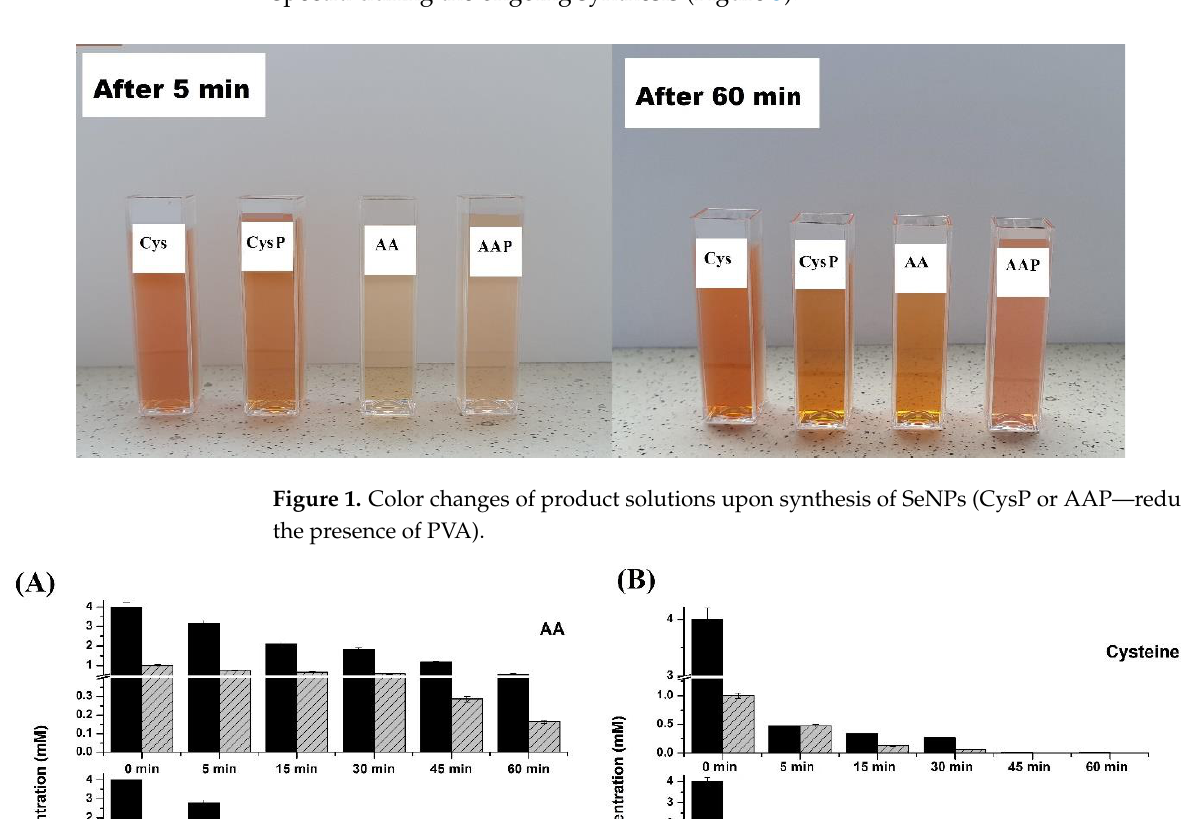
Figure 1. Color changes of product solutions upon synthesis of SeNPs (CysP or AAP — reductant in the presence of PVA).